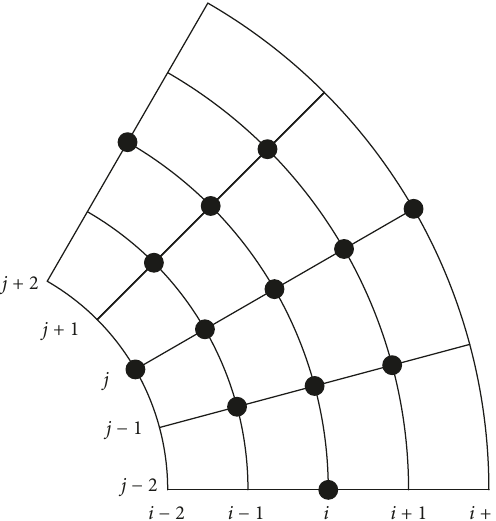
Table 1: Bearing